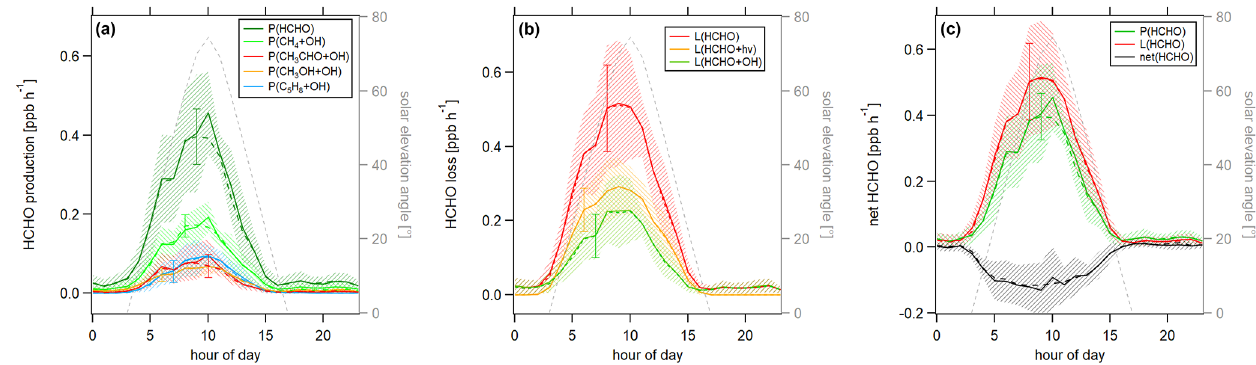
Figure 7. Diurnal profiles of (a) HCHO production P (HCHO), (b) HCHO loss L (HCHO) and (c) HCHO net terms during the CYPHEX campaign in 2014. Solid lines show the hourly averaged HCHO production and loss terms, based on the point-by-point calculation of simultaneous parameter measurements. The uncertainty from the atmospheric variability is represented by the 1 σ error shades. For the dashed lines, all measurement parameters were averaged first, followed by the calculation of hourly HCHO production and loss terms. The uncertainty is based on the atmospheric variability of all parameters and is exemplarily shown by the error bar for one point for each production and loss term. The gray dashed line represents the diurnal solar elevation angle at the measurement site, as determined by help of the NOAA Solar Calculator